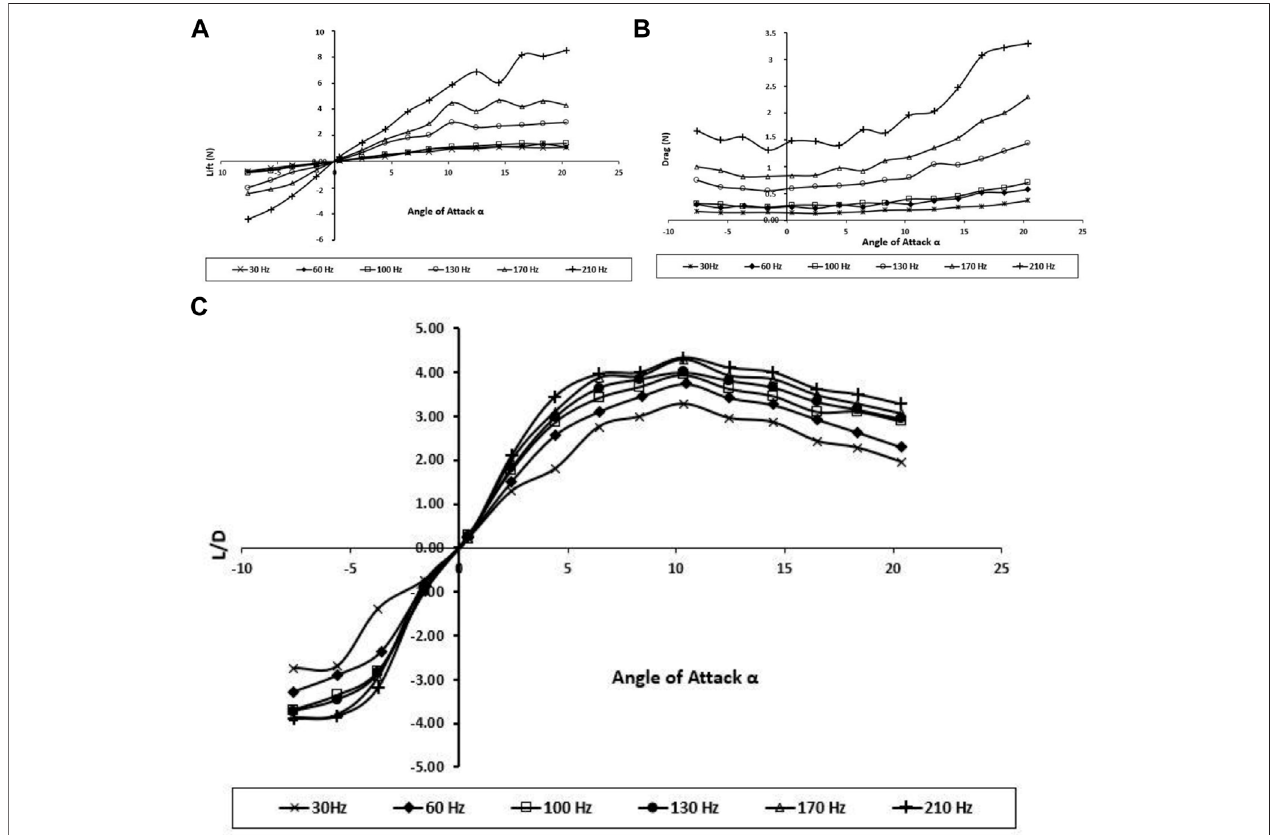
FIGURE 11 | Effect of tandem wings on (A) Lift force; (B) drag force; and (C) lift-to-drag